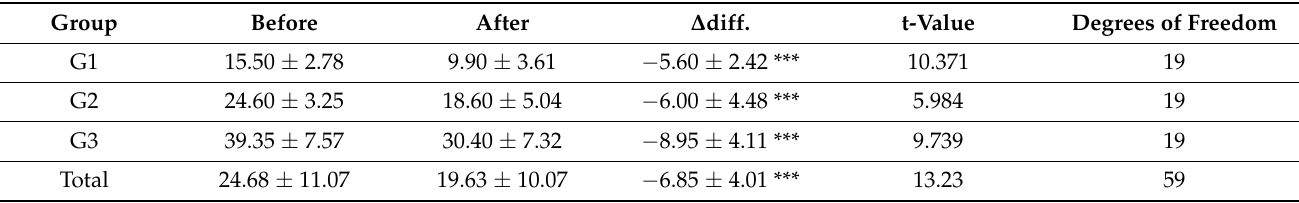
Table 3. Cobb’s angle readings in each group.